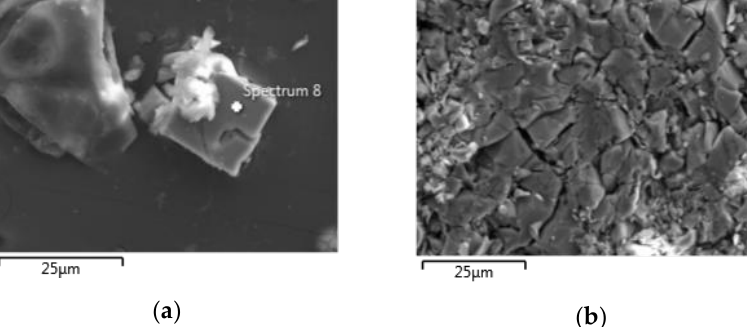
Figure 11. FESEM images of salts deposits and encrustations formed at the surface of the samples after 2 weeks of immersion in artificial urine: ( a ) polyHEMA@ZnO_0.1% and ( b ) polyHEMA@ZnO_1%.